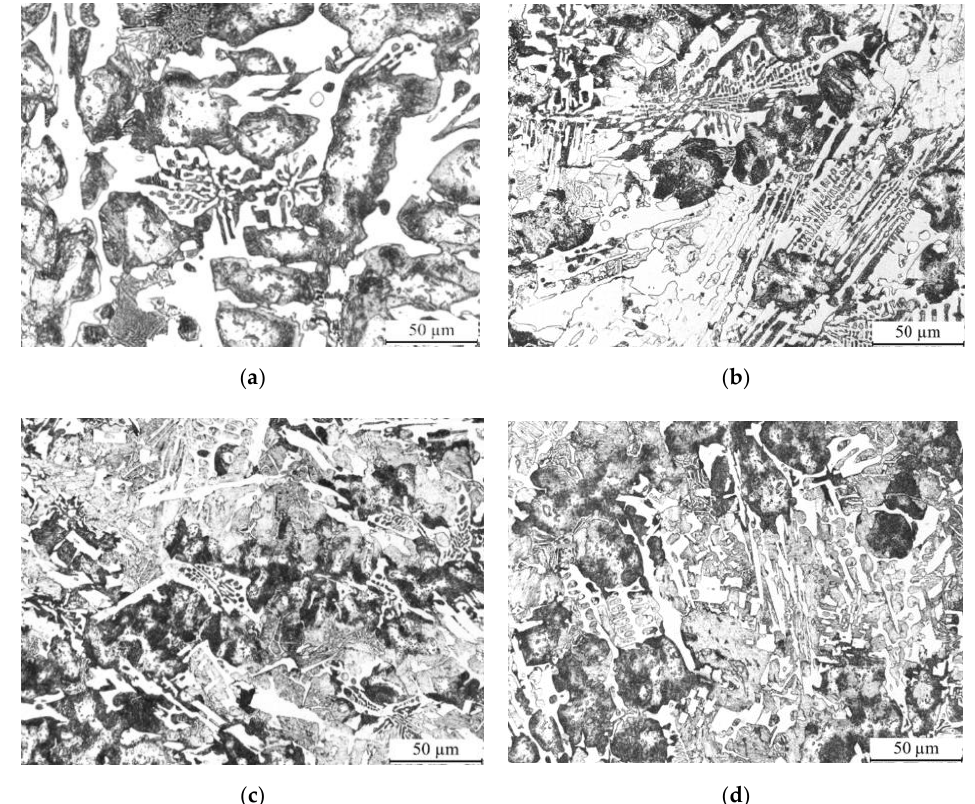
Figure 3. As-cast morphology of high-boron multi-component alloy with different Ti contents: ( a ) M, 0.0 wt.%, ( b ) T1, 0.2 wt.%, ( c ) T2, 0.4 wt.%, ( d ) T3, 0.6 wt.%.